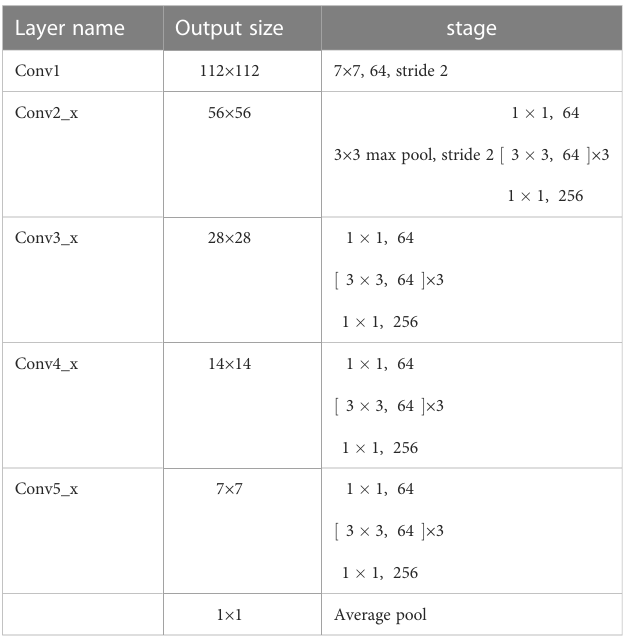
TABLE 1 Convolution layer and output image size of Resnet50 at each stage.